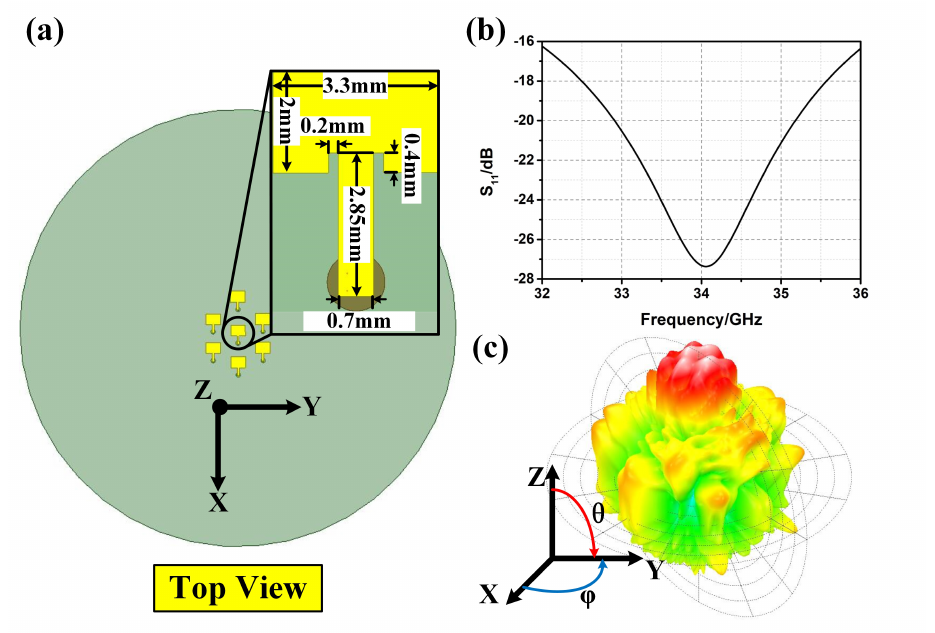
Figure 1. ( a ) The schematic of the broadband circular array (BCA); ( b ) the simulated reflection coefficient S 11 of the broadband antenna element; ( c ) the radiation pattern of the